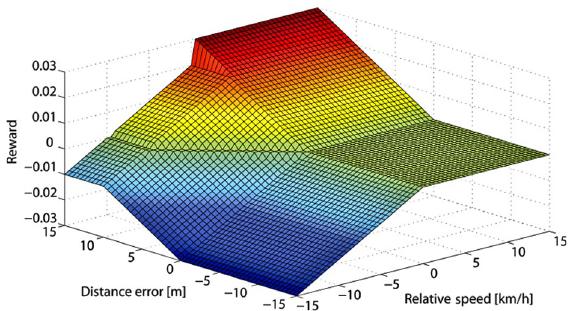
Fig. 4. Reward according to the input values